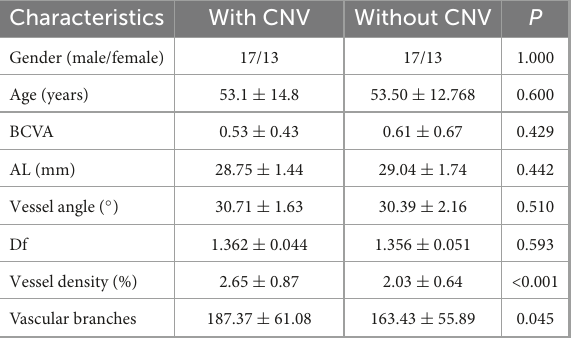
TABLE 4 Demographic and morphological characteristics of HM patients with and without CNV.